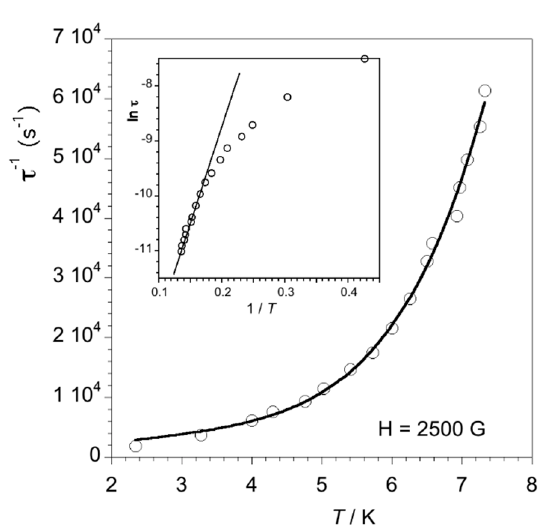
Figure 8. Temperature dependence of τ − 1 (o) for 1 under H dc = 2500 G showing the best-fit (solid line) to the combination of a direct and one Raman approach. The inset is the Arrhenius plot (o) showing the best-fit (solid line) to one Orbach process.